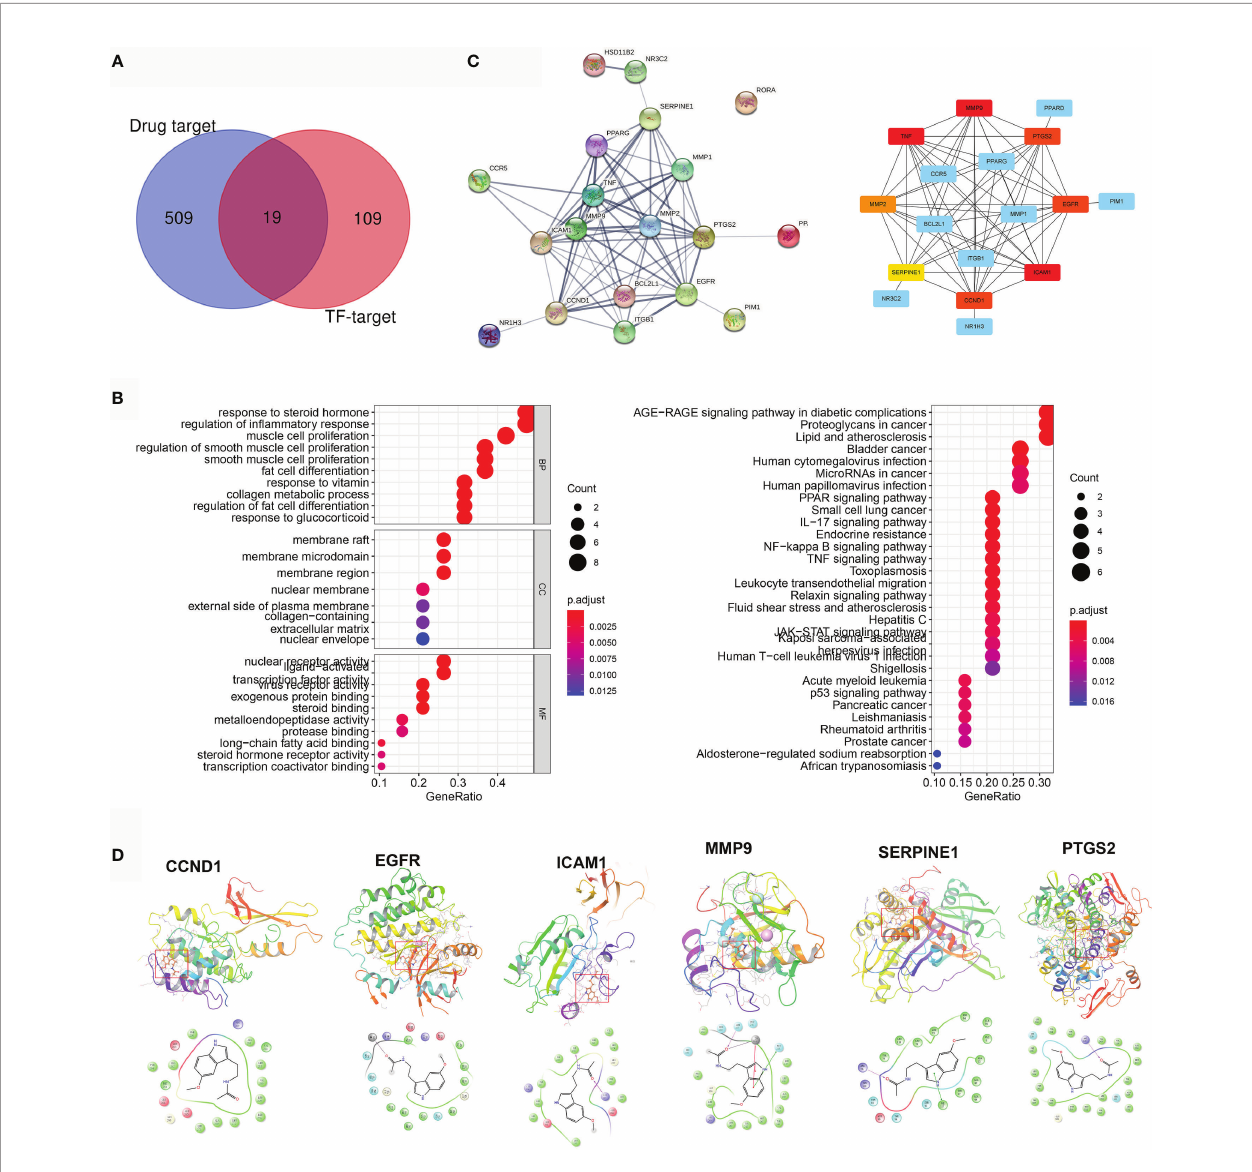
FIGURE 4 | Pharmacological targets of melatonin (MLT) in AD and rosacea. (A) Nineteen intersection genes of MLT against AD/rosacea. (B) GO and KEGG enrichment analysis of the 19 MLT targets. (C) PPI network of the 19 MLT targets. (D) Molecular docking revealed the binding of MLT to its